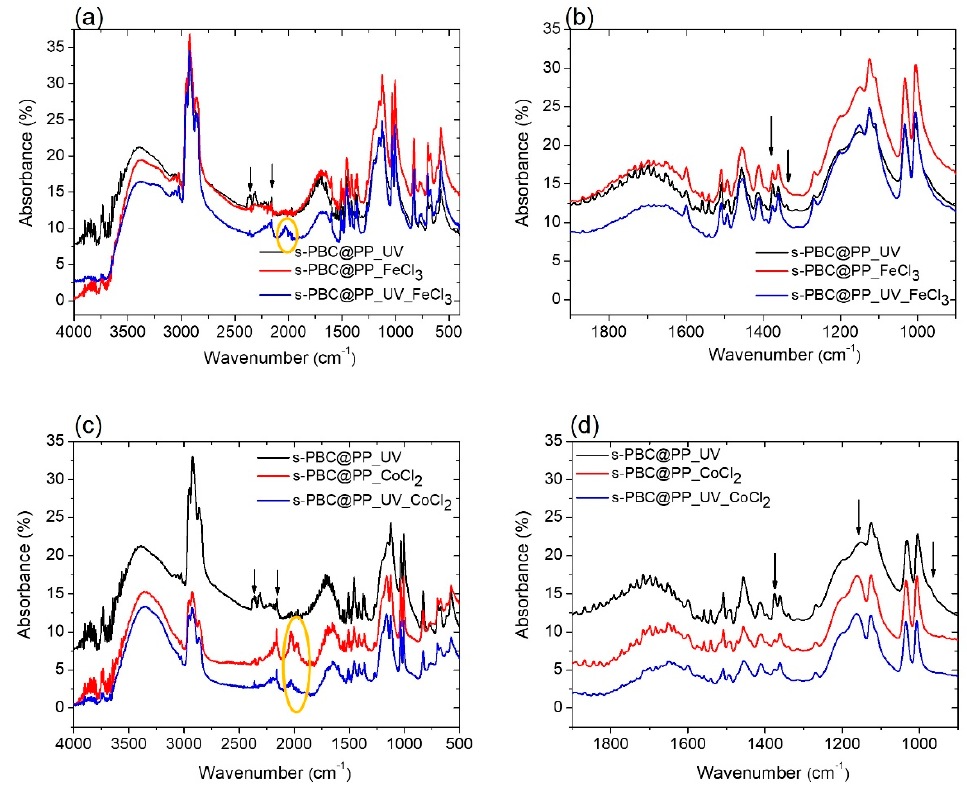
Figure 6. FT-IR spectra of ( a , b ) s-PBC@PP filter (red line) and UV-treated s-PBC@PP filter (blue line) after being dipped in a FeCl 3 solution; ( c , d ) s-PBC@PP filter (red line) and UV-treated s-PBC@PP filter (blue line) after being dipped in a CoCl 2 solution. The ( b , d ) figures show more in detail the 1900–900 cm − 1 range. FT-IR spectra of the s-PBC@PP filter after UV treatment is reported in all the graphs as a reference (black line).